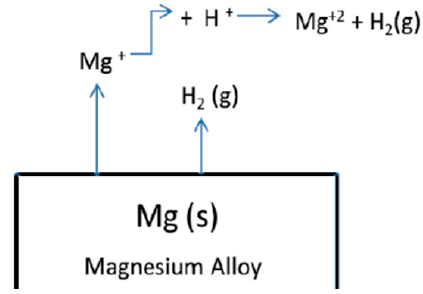
Figure 17. Monovalent magnesium ion model. Modified from [85].